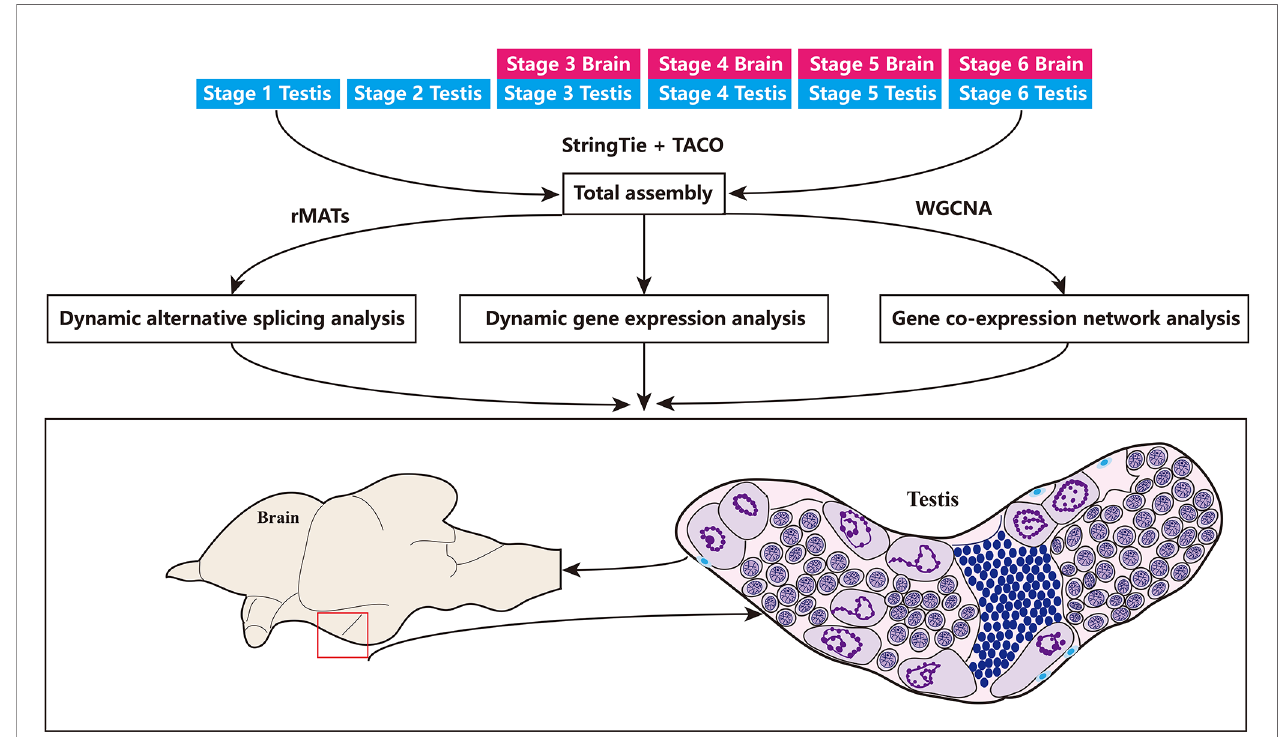
FIGURE 2 | Overview of the study. Samples used are listed on the top, including 4 stages in the brain and 6 stages in the testes. This data set was fi rst used for transcriptome assembly, then for dynamic gene expression quanti fi cation and alternative splicing analysis, as well as for gene co-expression network analysis in the brain and